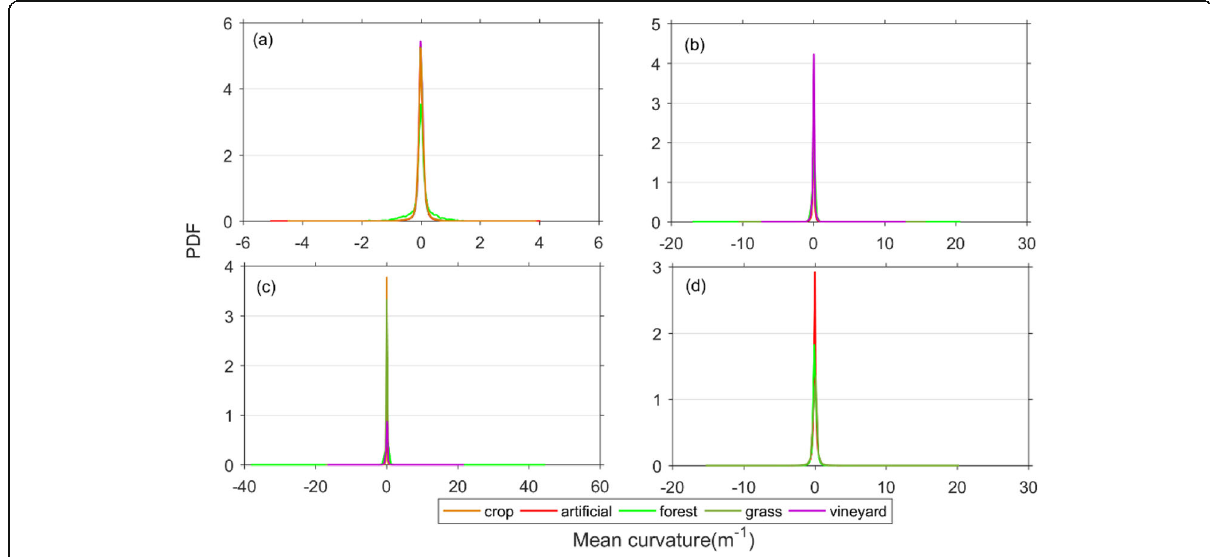
Fig. 10 The PDFs of the mean curvature with different land covers in the four areas: a floodplain, b plain to hilly, c hilly, d